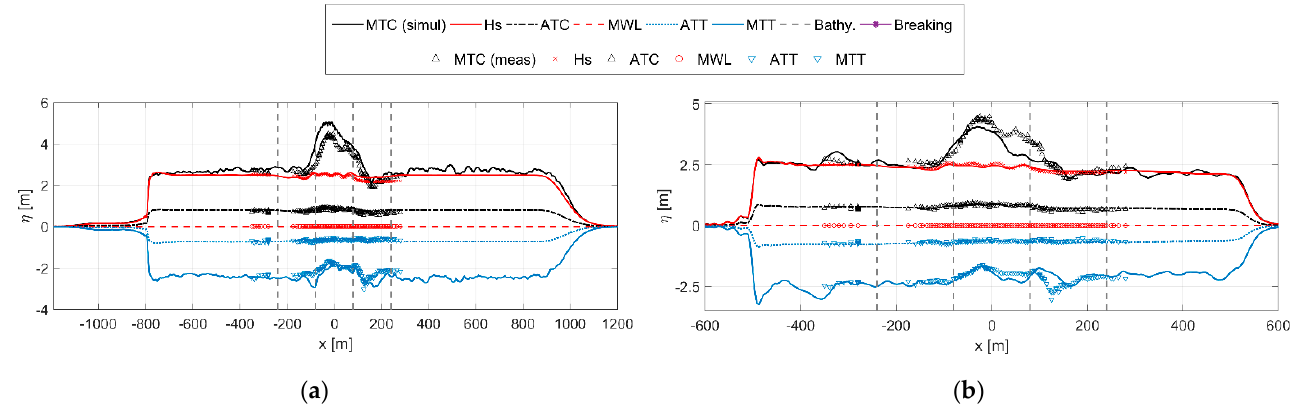
Figure 6. ( a ) the wave-print for the simulation with 1D long-crested waves over the shoal of the experiment with waves Hs = 2.5 m, Tp = 11 s; this case had the largest kurtosis for non-breaking waves in the list [5]. ( b ) the wave-print for the simulation, with short-crested waves for comparison.